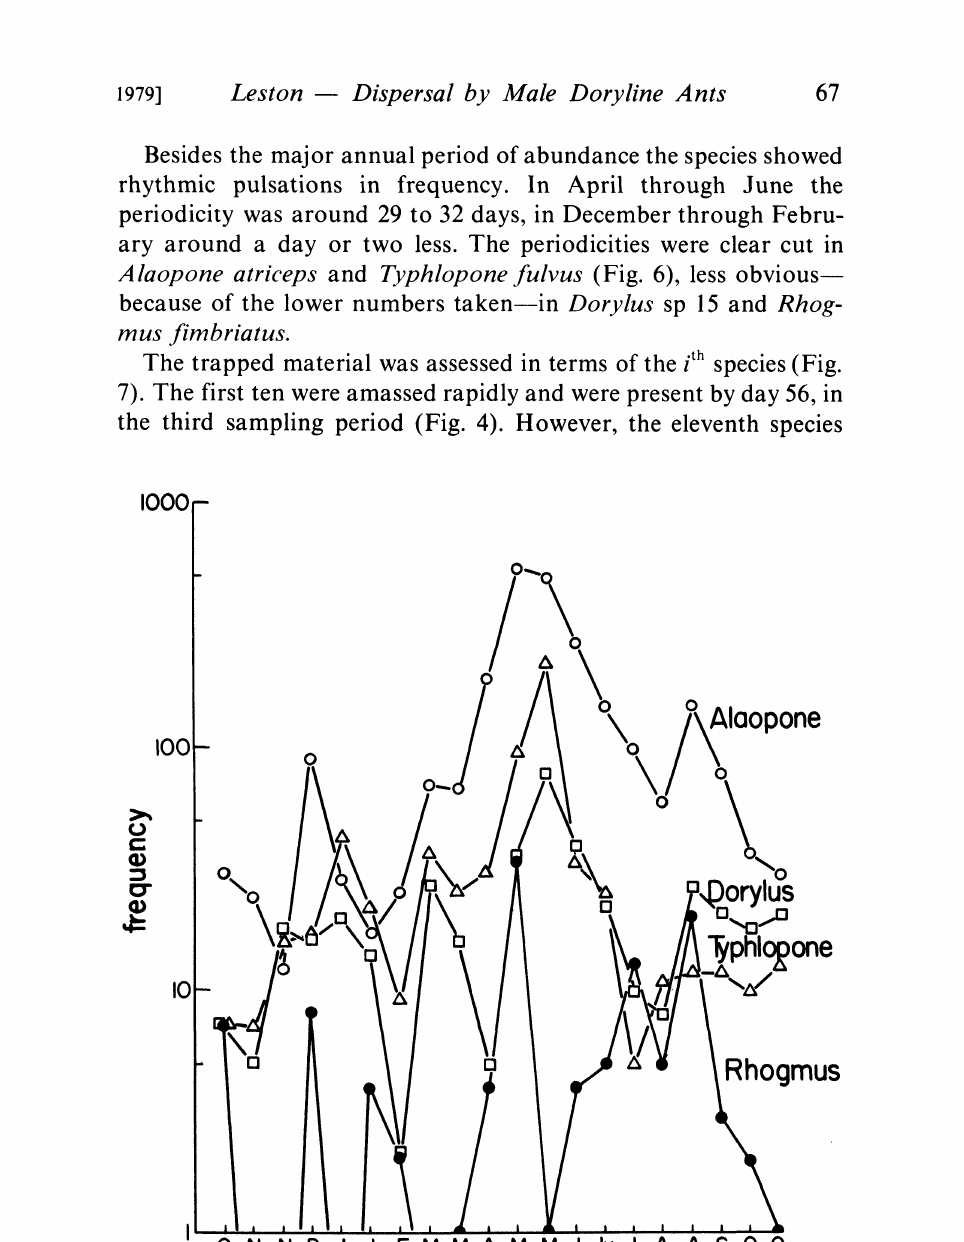
Fig. 4. Totals of the four most abundant species in the Legon samples, logarith- mic, grouped in 20-day